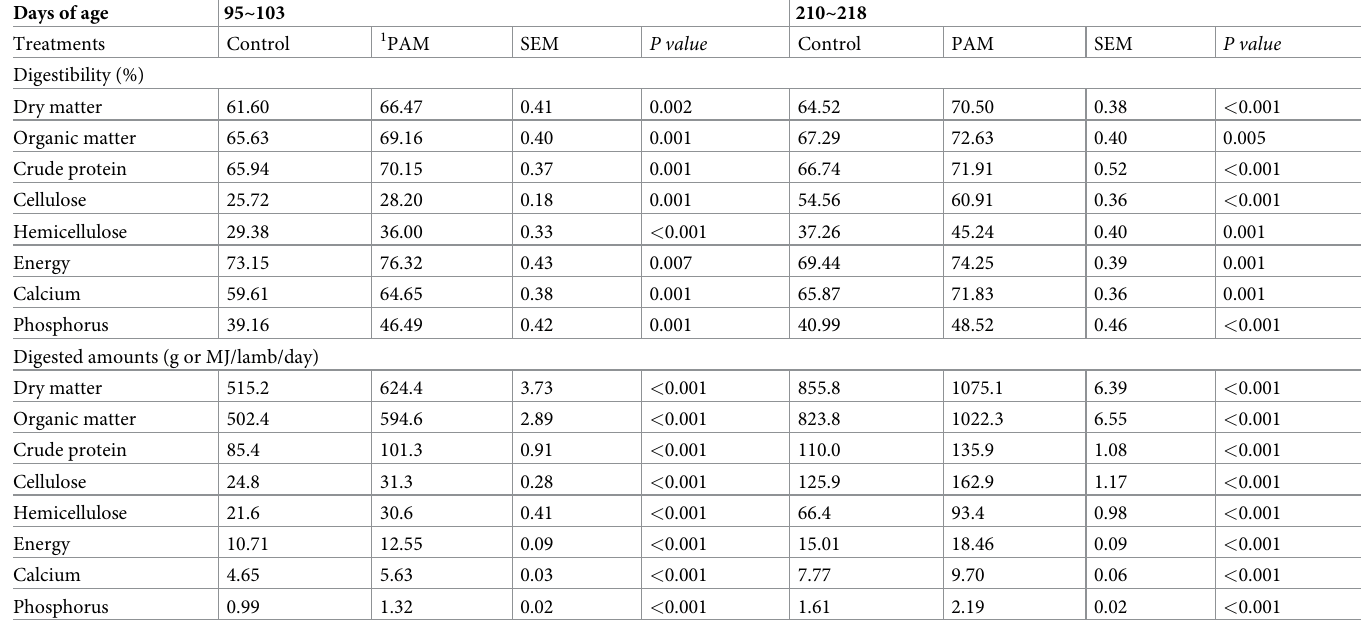
Table 3. The effect of supplementation with polyacrylamide on the apparent digestibility and the amounts of digested nutrients in the diet of lambs. Days of